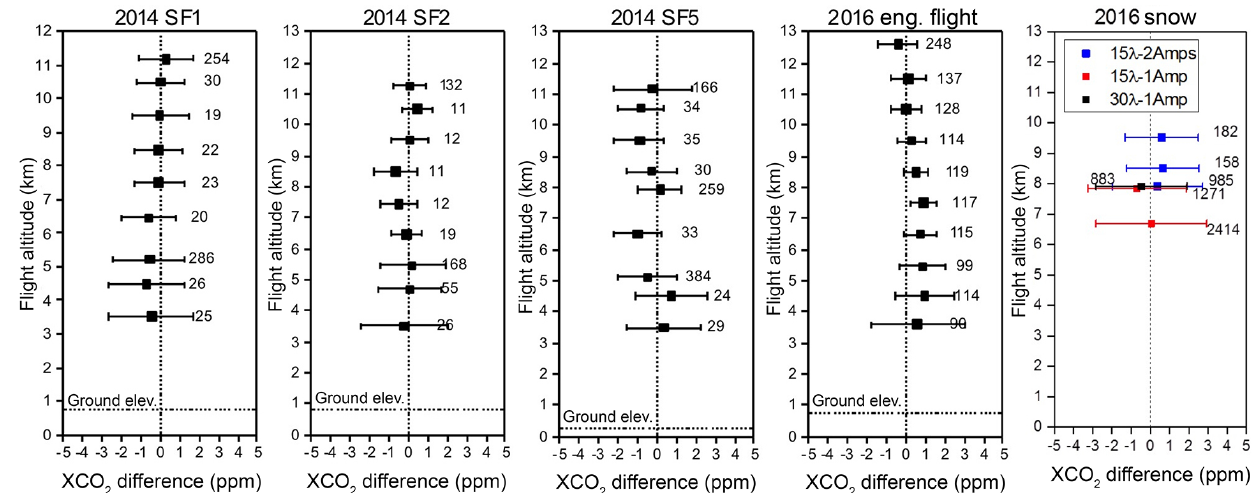
Figure 26. Summary of results from the 2014 and 2016 flights, plotted from the values summarized in Tables 3 and 4. The dots are the mean value of the XCO 2 from the lidar minus that computed from the in situ sensor. They are plotted at the altitude from which they were measured, and the average ground elevations are also shown. The 2014 statistics are from data using 10s averaging and the 2016 measurements used 1s averaging. The error bars are those of the lidar data set, and the numbers shown are the number of lidar observations in that set. There were three different settings used in the lidar for the 2016 snow flight, and their results are plotted in different